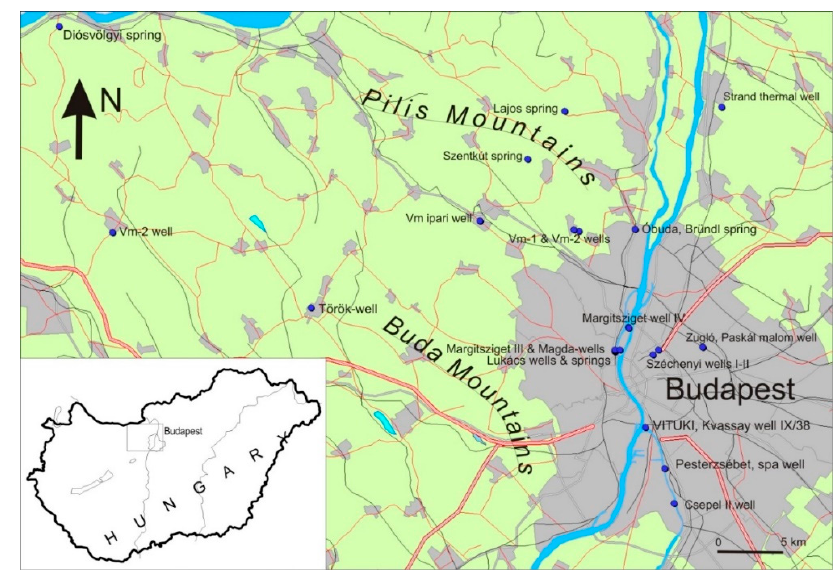
Figure 1. The location of the studied area in Hungary, and the sampling locations (blue dots) in Budapest and its surroundings.